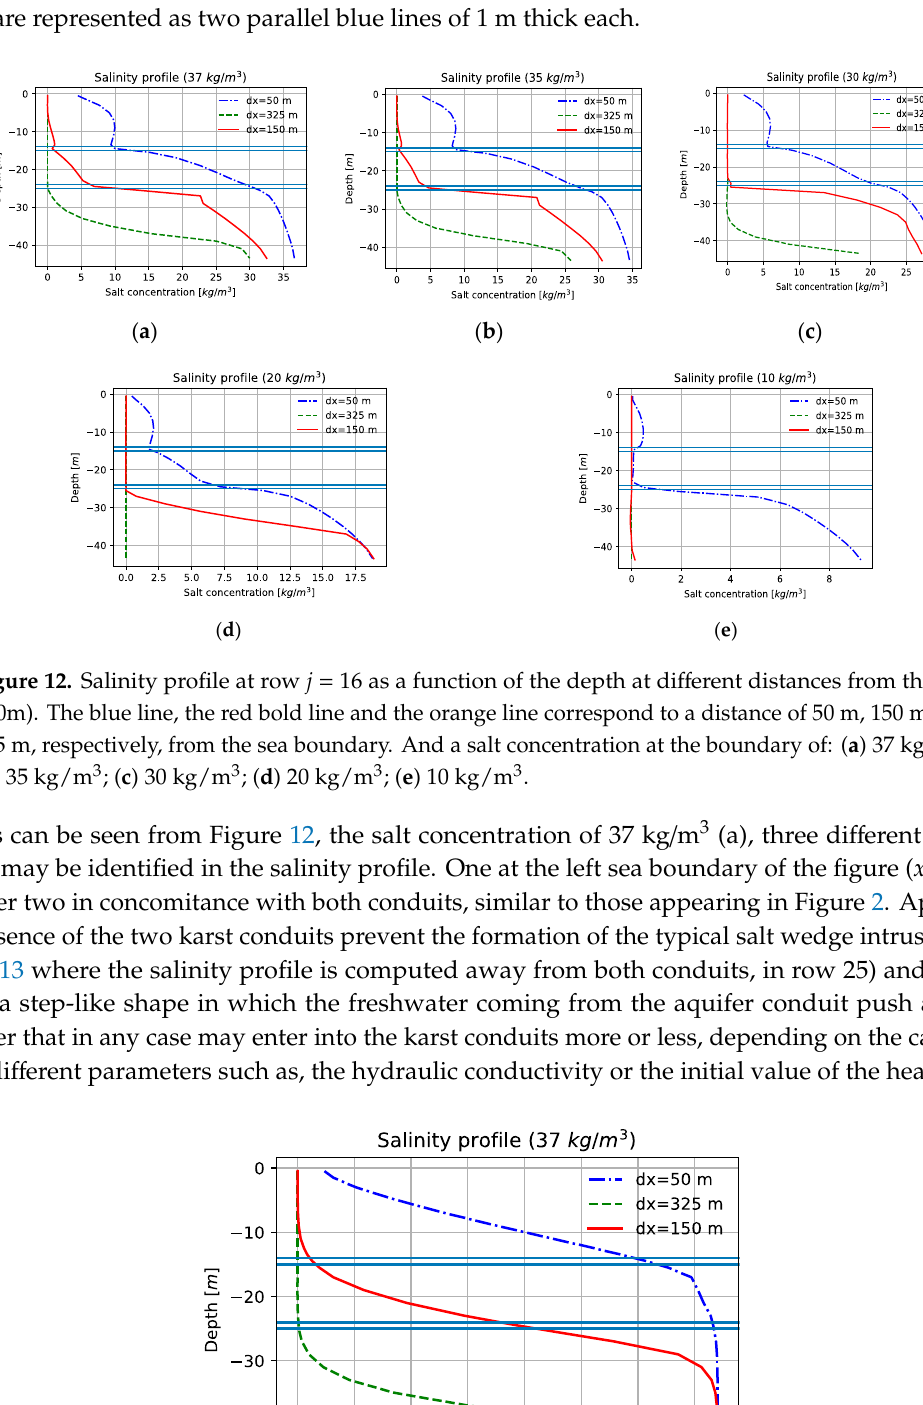
( b ) Figure 11. Nonlinear relationship between: ( a ) Salinity and salt concentration; ( b ) Salinity and HDf both in the fractured medium away from the conduits using the locations where the Css are maximum. 3.4. Numerical Simulations Results of Seawater Intrusion Scenarios After having determined the important parameters of the model, i.e., SC and HCf inside the second conduit, and using the values of the porosity and longitudinal dispersion in both, conduits and fractured medium from [21], where a series of transient simulations were performed in order to calibrate the model and determine the best choice of parameters, we investigated various scenarios of saltwater wedge shape and examined which were the parameters that most influence the extension